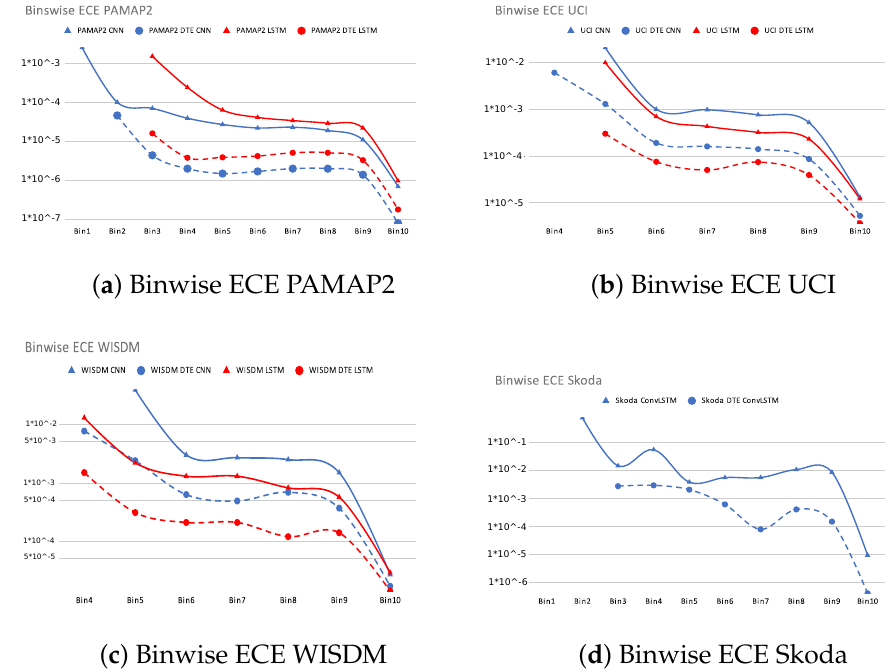
Figure 6. Binwise ECE (along y -axis) of all datasets and selected architectures.